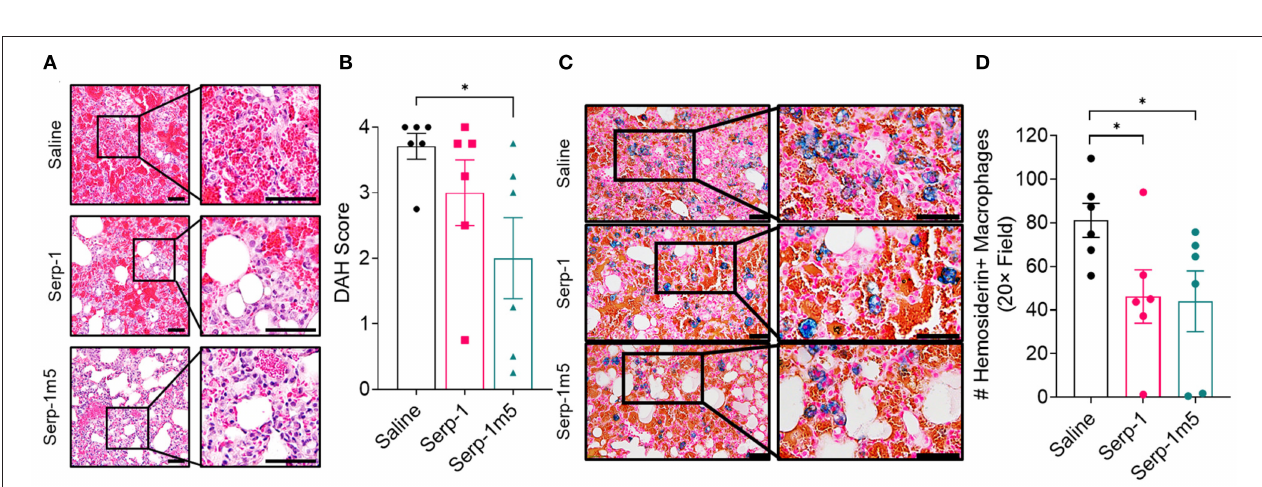
FIGURE 1 | Serp-1 and its reengineered derivative Serp-1m5 reduce the prevalence of hemorrhage in pristane induced DAH mouse model. All mice induced by pristane were euthanized by CO 2 on the 15th day of treatments with saline (6 mice), Serp-1 (6 mice), or Serp-1m5 (6 mice). Whole lungs from mice in each group were collected (A) and examined based on four grades of hemorrhage: severe, moderate, mild, or none (B) .